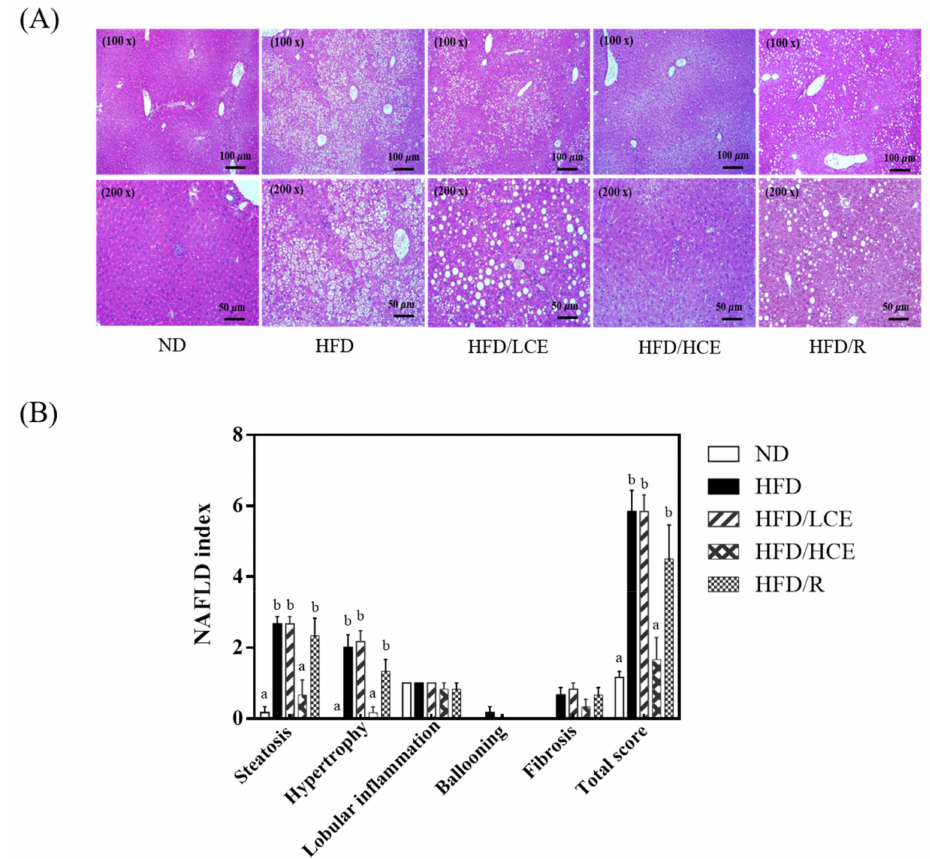
Figure 5. Effect of Djulis hull crude extract and rutin on pathological indices in HFD-induced obese mice. ( A ) Representative hematoxylin and eosin staining of liver sections. ( B ) NAFLD index calculated from individual scores for steatosis, hypertrophy, lobular inflammation, ballooning and fibrosis. ND: normal diet; HFD: high-fat diet; LCE: low dosage of crude extract; HCE: high dosage of crude extract; R: rutin. Values represent the mean ± SEM (n = 6). Statistical methods were used by one-way ANOVA, and the different letters are significantly different at p <